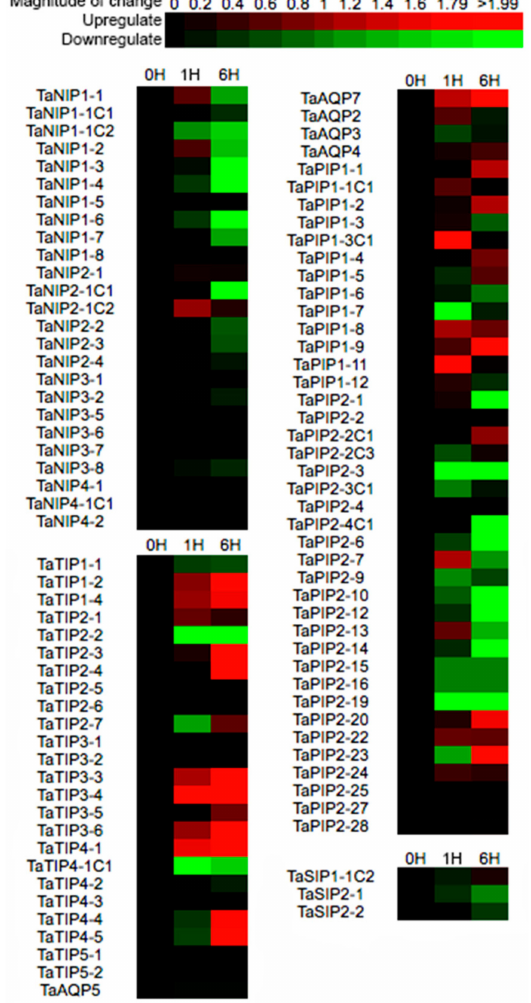
Figure 6. Analysis of AQP gene expression of wheat seedling leaves under osmotic stress. Green indicates a negative change or down-regulation and red indicates a positive change or up-regulation at 1 or 6 hours after treatment. The intensity of the colors indicates the fold change. Microarray data were obtained from